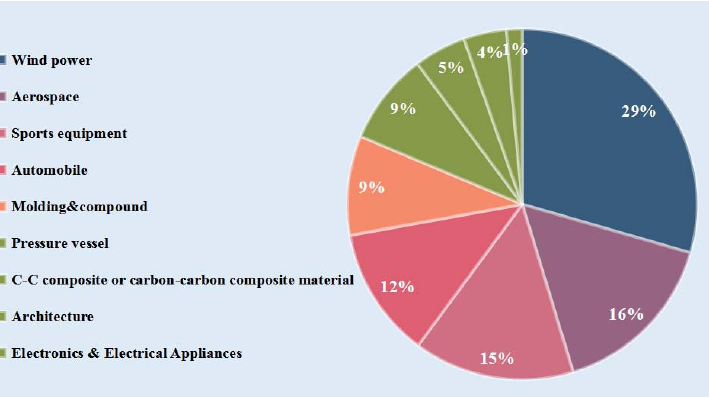
Figure 3. Global demand for CFs in various application fields in 2022 (in